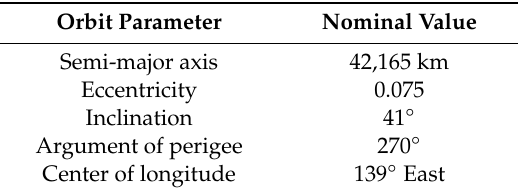
Table 4. Quasi-Zenith orbit (QZO) parameters [29].